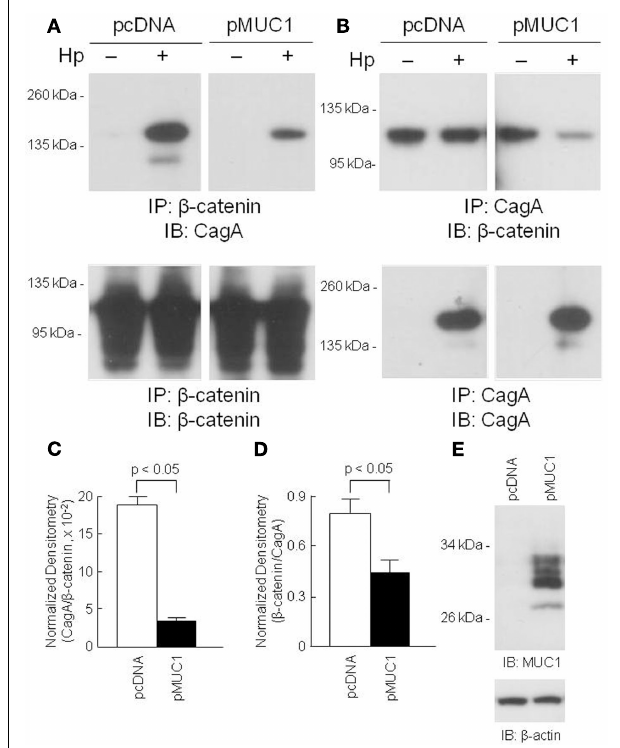
FIGURE 4 | Over-expression of MUC1 reduces CagA/ β -catenin co-immunoprecipitation. AGS cells were transfected with the pcDNA empty vector or the pMUC1 expression plasmid. At 24h post-transfection, the cells were untreated or were treated with H. pylori (Hp) at an MOI of 100. At 24h post-infection, the cells were washed and cell lysates were immunoprecipitated with antibodies to β -catenin (A) or CagA (B) . Immunoprecipitated proteins were resolved by SDS-PAGE, transferred to PVDF membranes, and processed for immunoblotting with antibodies to CagA (A) or β -catenin (B) .To control for to control for protein loading and transfer, blots were stripped and reprobed with the same antibody used for immunoprecipitation. Molecular weight markers are indicated on the left in kilodaltons (kDa). (C) Densitometry of the blots in (A) . (D) Densitometry of the blots in (B) . Each bar represents the mean ± SEM value of the density of the CagA band normalized to the β -catenin band [from (A) ], or the β -catenin band normalized to the CagA band [from (B) ], in Hp-treated cells ( n = 3). (E) Increased MUC1 expression in AGS cells transfected with the pMUC1 plasmid.The results are representative of two experiments.